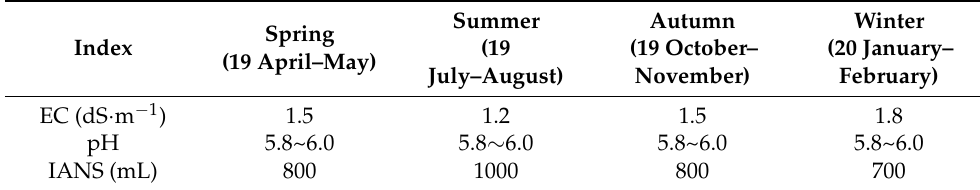
Table 2. Nutrient solution supplied in the hydroponic system during the